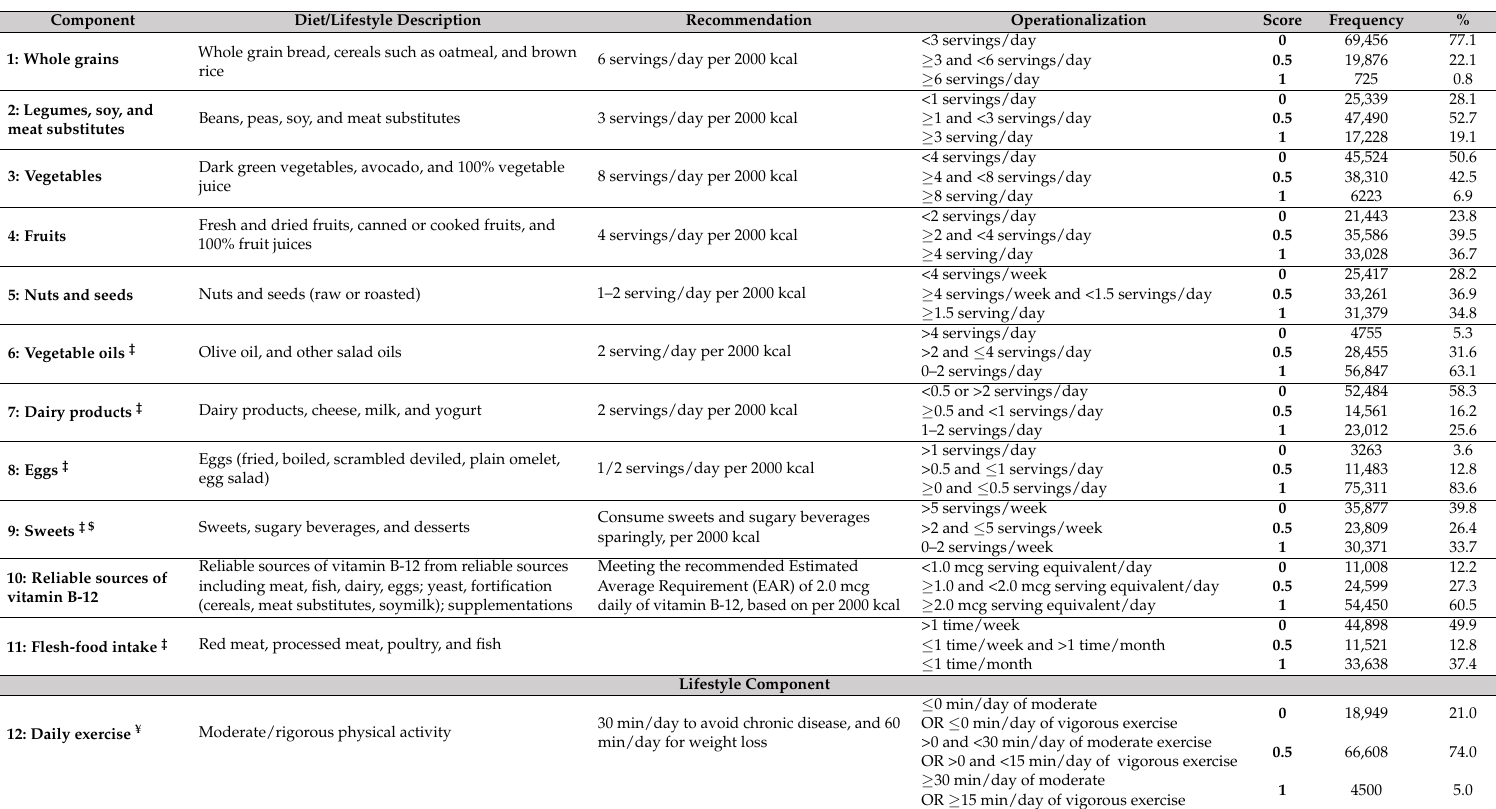
Table 1. Operationalization of Vegetarian Lifestyle Index (VLI) based on the LLU-Vegetarian Food Guide Pyramid Recommendations. Component Diet/Lifestyle Description